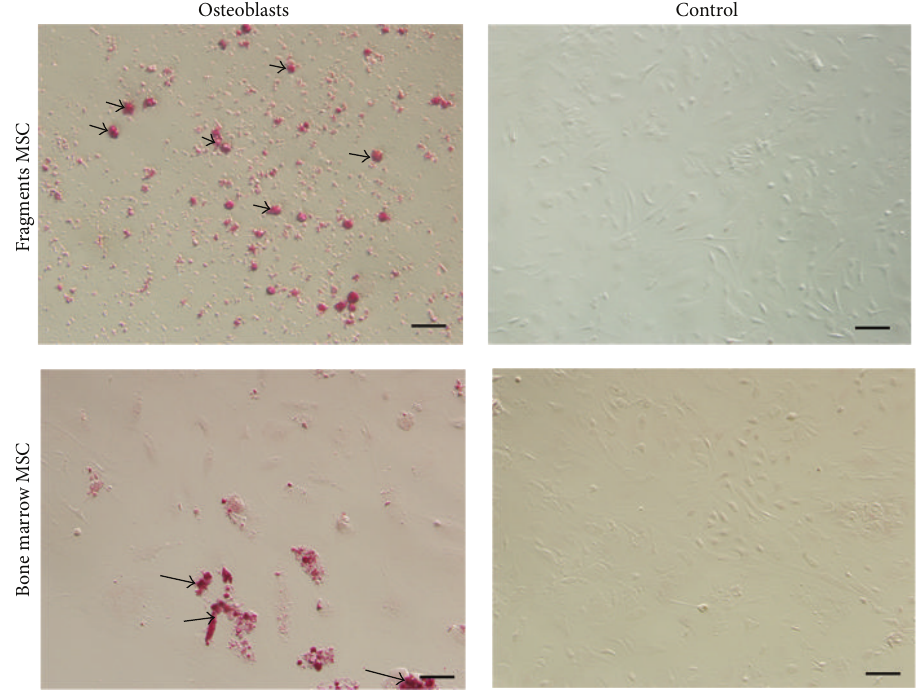
Figure 5: Cell osteogenic differentiation of the first passage from cultured bone marrow and bone fragments. Arrow showed the calcium nodules stained by alizarin red. Bar 50 𝜇 m.